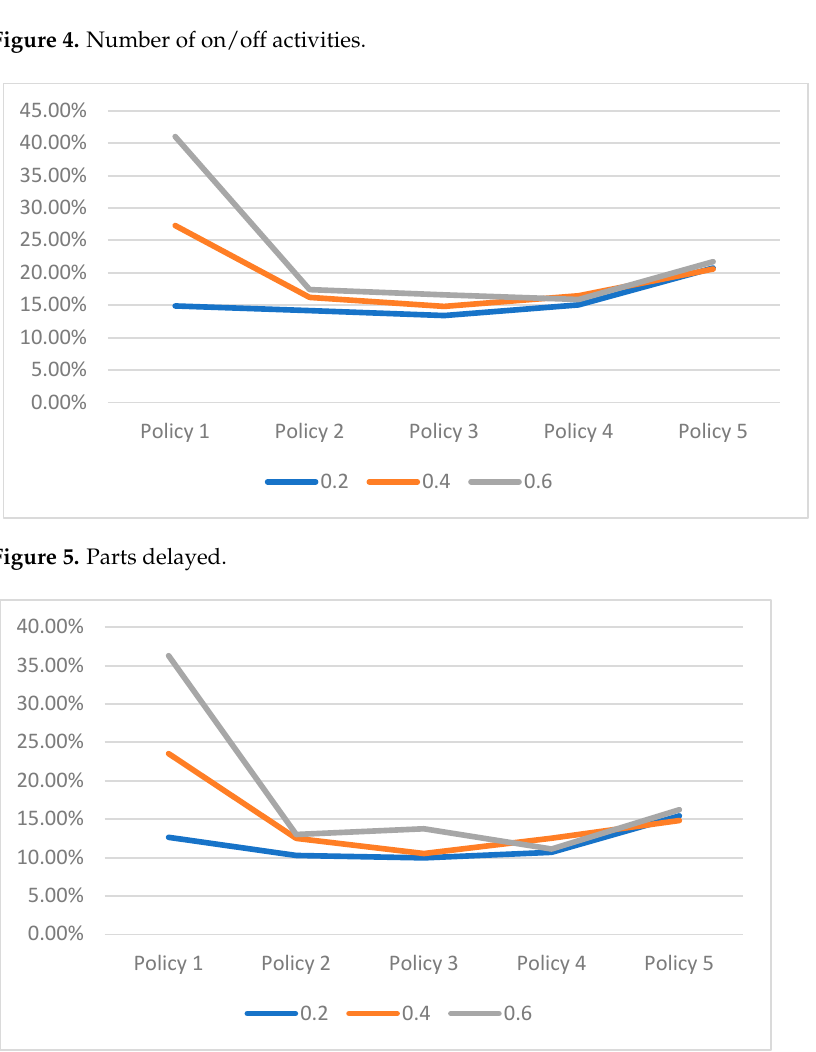
Figure 6. Total time delay.